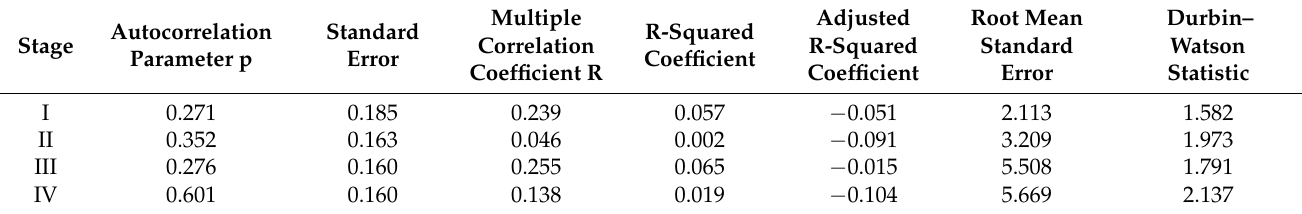
Table A1. Cochrane–Orcutt estimation results.